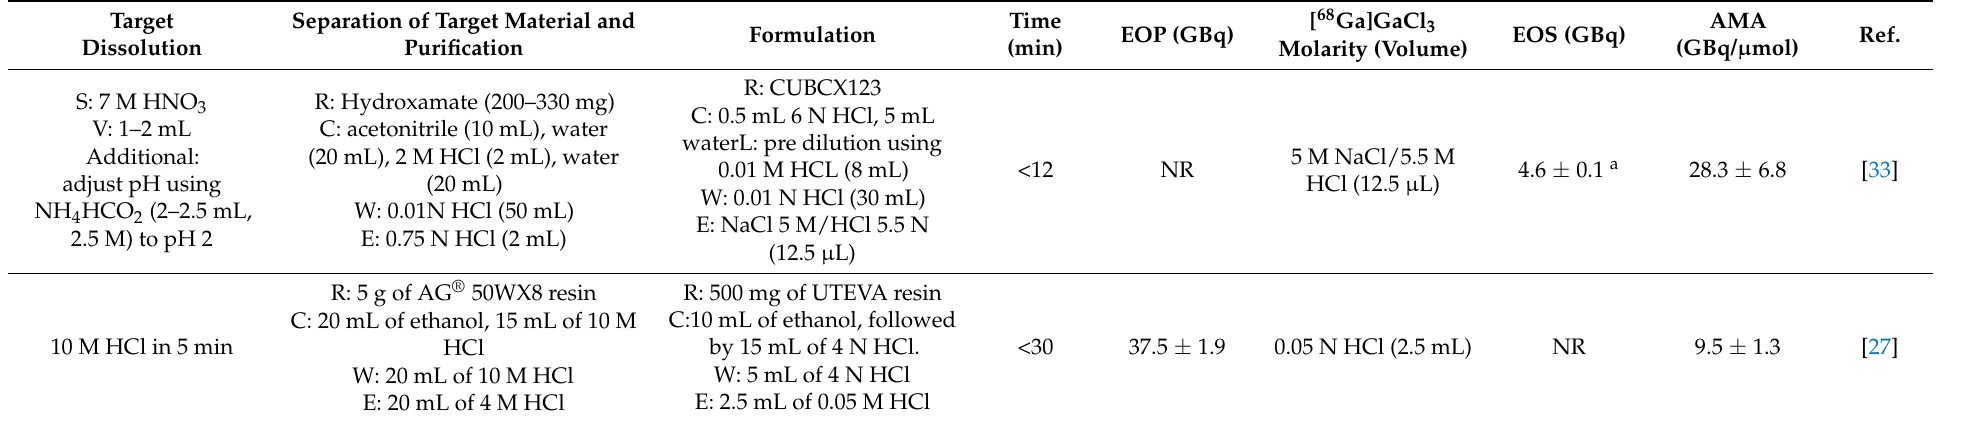
Table 3. Dissolution of solid target for TR cyclotron and purification of [ 68 Ga]GaCl 3